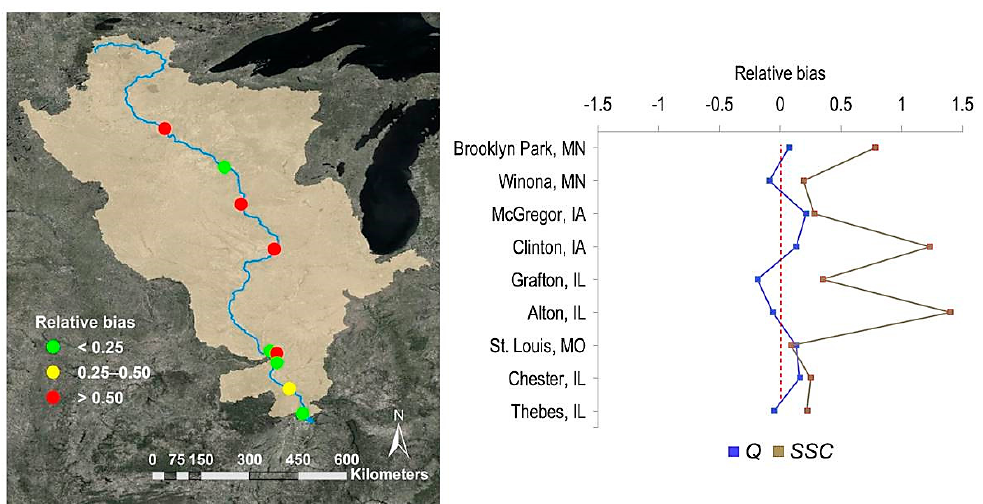
Figure 13. Effect of relative biases in Q and SSC estimation on sediment discharge estimation for the study sites in the Upper Mississippi River. Left panel: relative bias in sediment discharge estimation. Right panel: relative bias in Q and SSC estimation.